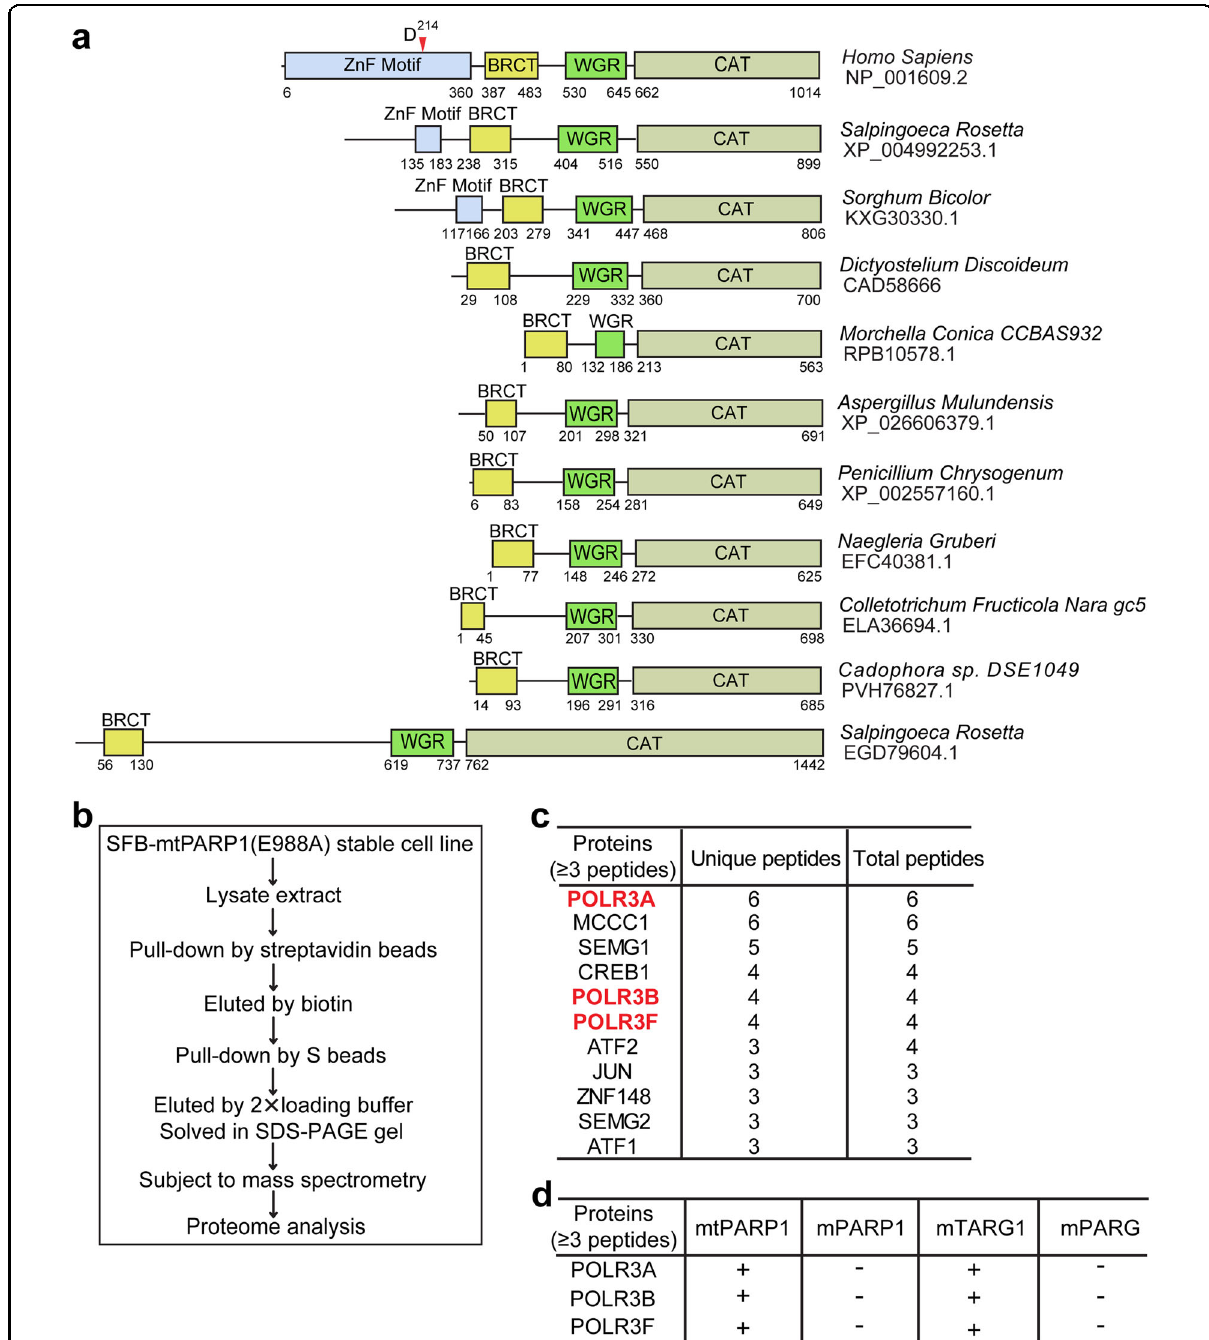
Fig. 1 Identi fi cation of Pol III complex as tPARP1-binding partners. a The domain architecture of human PARP1 and its orthologs in a set of lower eukaryotes. Caspase 3 cleavage site on human PARP1 is at D214. b A schematic representation of the tandem af fi nity puri fi cation assay to identify mutant tPARP1-binding partners. c List of the top 11 unique proteins with more than two unique peptides identi fi ed from mutant tPARP1 (mtPARP1) puri fi cation using mass spectrometry. d Pol III complex was only identi fi ed in the protein af fi nity puri fi cation using mtPARP1 and mutant TARG1 (mTARG1) but not from that using mutant PARP1 (mPARP1) or mutant PARG